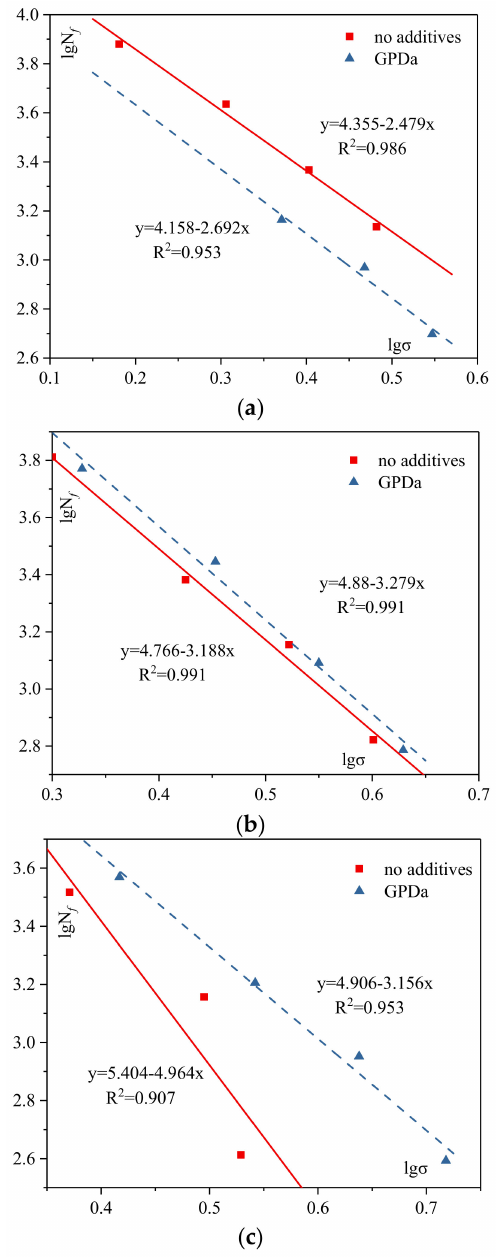
Figure 3. Curves for mixtures at di ff erent asphalt rubber contents (ARCs): ( a ) ARC of 6.4%; ( b ) ARC of 6.9%; ( c ) ARC of 7.4%. GPDa: Granular Polymer Durable